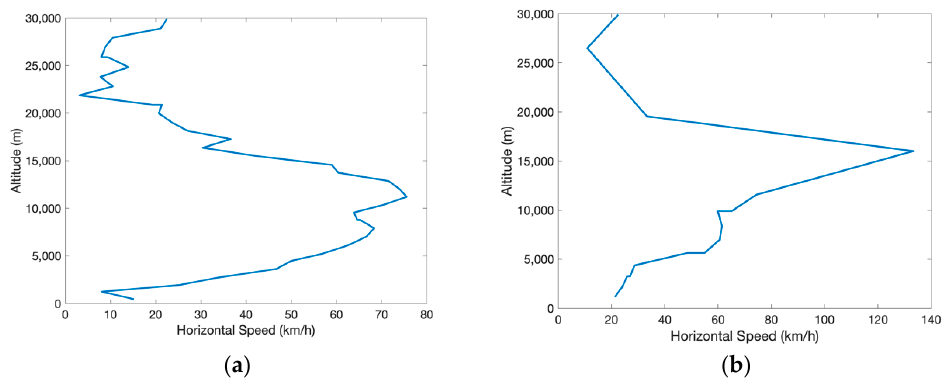
Figure 17. Horizontal speed during flight ISM-HAB #3: ( a ) during ascent and ( b ) during descent.